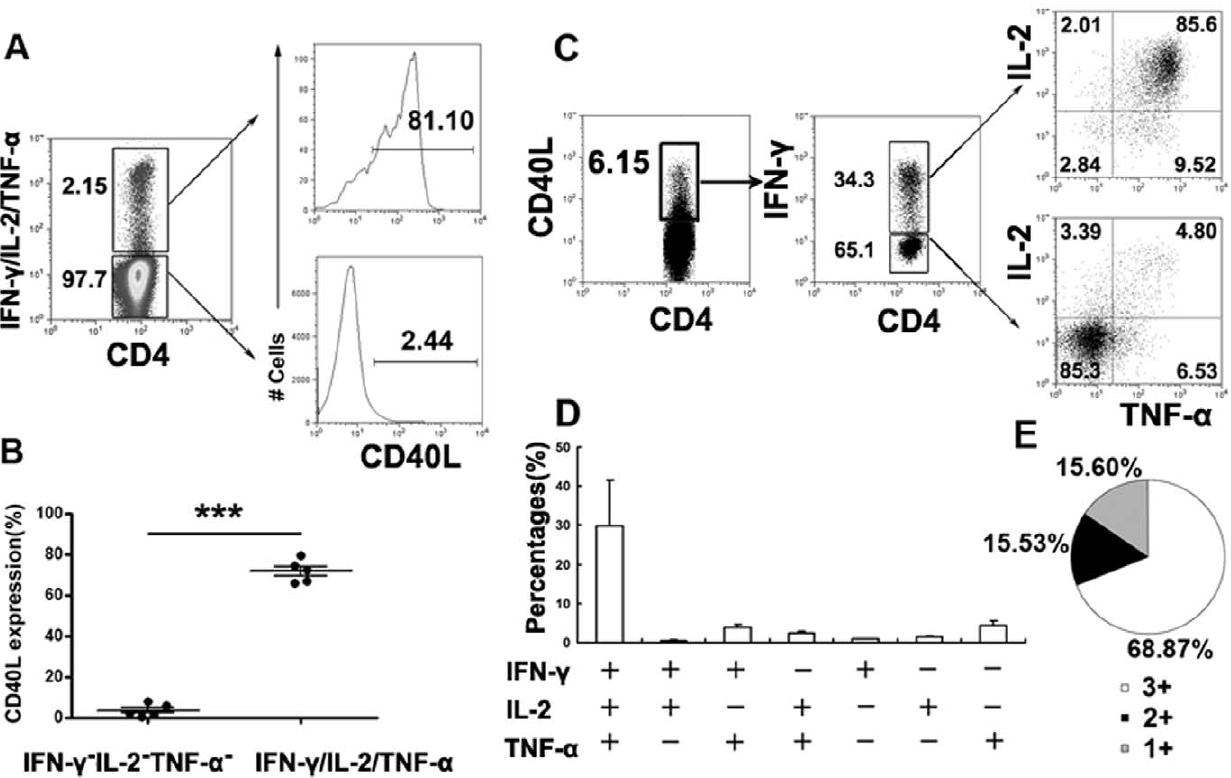
Figure 3. CD4 + CD40L + T cells express polyfunctional cytokines. PFCs were stimulated with ESAT-6/CFP-10 peptides, anti-CD28 and anti- CD49d mAbs for eight hours. For detection of intracellular cytokines, anti-IFN- c , anti-IL-2 and anti-TNF- a monoclonal antibodies were labeled with the same fluorescence. The staining of CD40L and cytokines of IFN- c /IL-2/TNF- a were conducted in one FACS tube.(A) Th1 cytokine (IFN- c , IL-2 or TNF- a ) producing and nonproducing cells were gated. The expression of CD40L was evaluated. (B) Summary of the CD40L expression data within Th1 cytokine producing and nonproducing cells. Horizontal lines represent mean 6 SEM. (C) CD4 + IFN- c + and CD4 + IFN- c 2 cells within CD4 + CD40L + T cells were further gated, and the expression of IL-2 and TNF- a are shown. (D) The total antigen response within CD4 + CD40L + T cells was defined as the number of cells expressing any combination of IFN- c , IL-2 or TNF- a . The average percentages for each subset are shown. (E) The percentages of cells producing three cytokines (triple positive), two cytokines (double positive) or only one cytokine (single positive) within the total CD4 + CD40L + T cell response. Data shown are the mean values from five independent experiments.